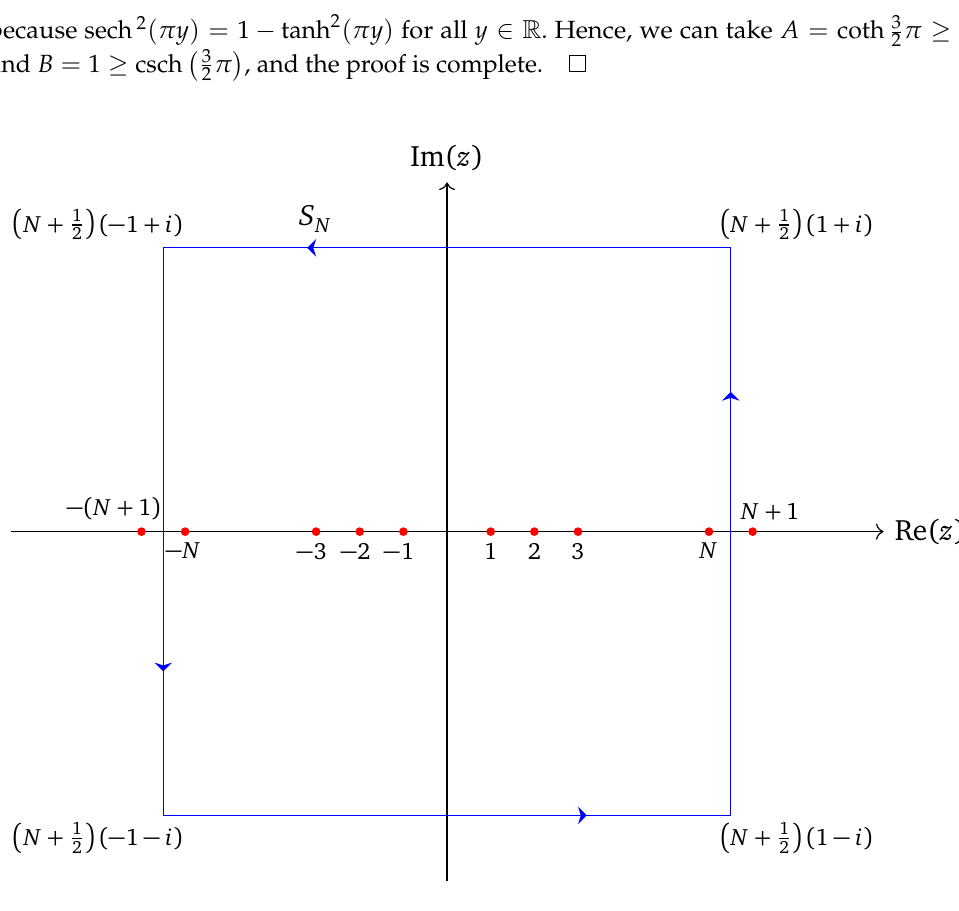
Figure 4. The square S N with vertices at